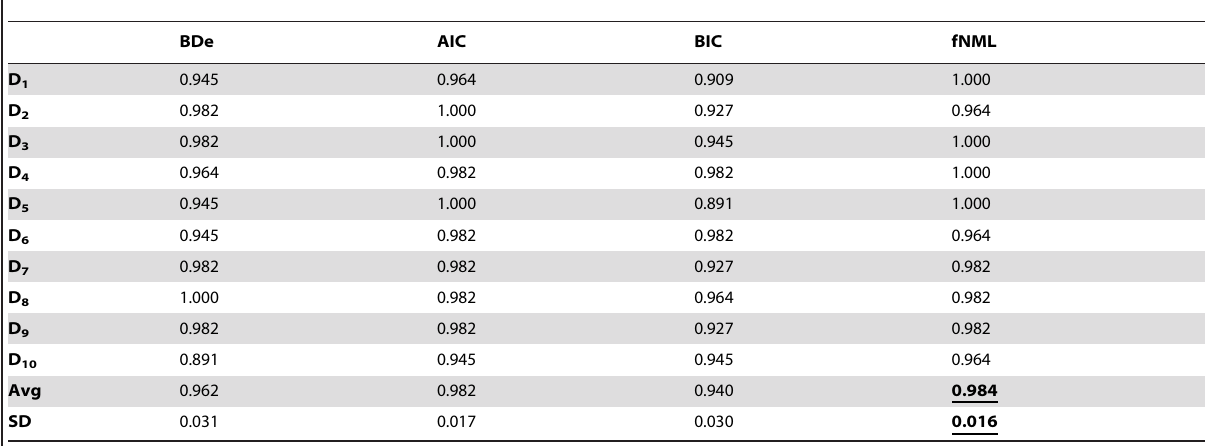
Table 2. Prediction accuracy of different scoring methods on synthetic datasets.